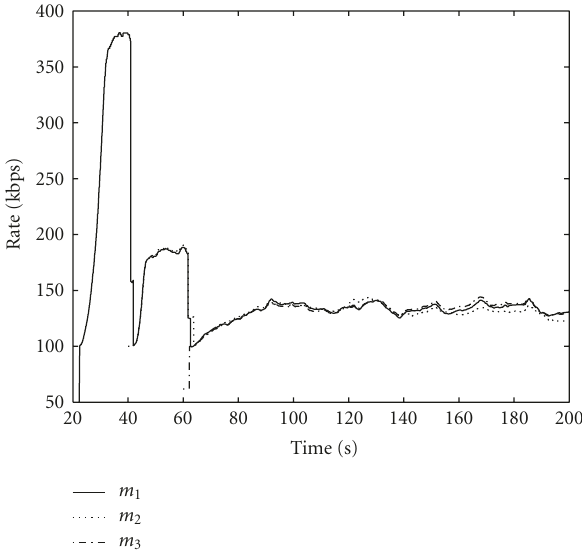
Figure 5: Convergence for time-varying channel capacity using IEEE 802.11 DCF